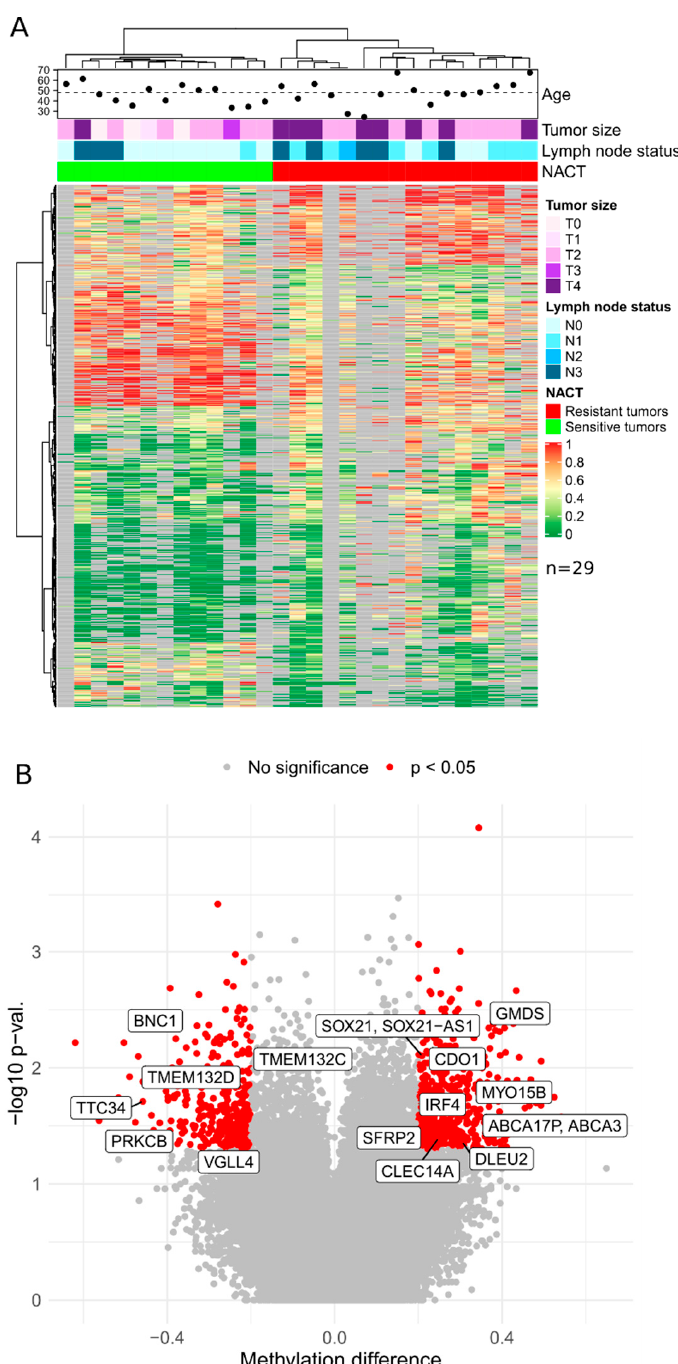
Figure 1. ( A ) Genome-wide bisulfite DNA sequencing (XmaI-RRBS) results from TNBC samples obtained before neoadjuvant chemotherapy. The heat map shows the level of methylation: red—100%, yellow—50%, green—0%, gray—missing data in NACT-sensitive and -resistant TNBC samples. Each row represents the methylation of a CpG dinucleotide in the samples by column. ( B ) Volcano plot indicating differentially methylated CpG-dinucleotides in TNBC tumors. X axis represents methylation difference between resistant and sensitive tumor samples; Y axis stands for − log10 scaled nominal p -value. Most informative CpG-pairs revealed by MSRE-qPCR in an independent cohort are marked with gene names they map to.